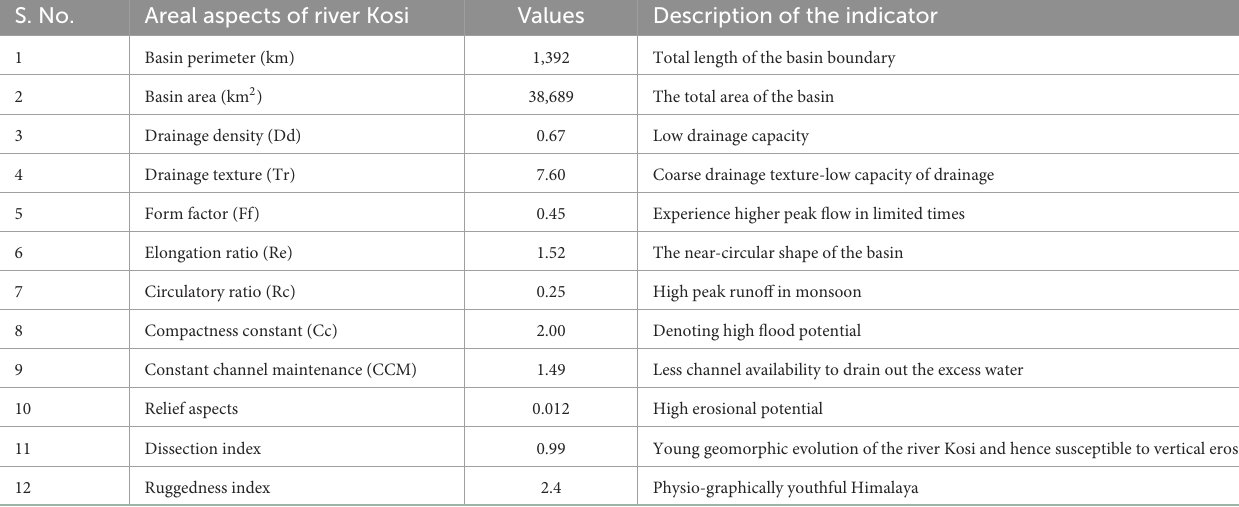
TABLE 1 Areal aspects of river Kosi (This table adapted from Mahala and Pathak, 2019). S.